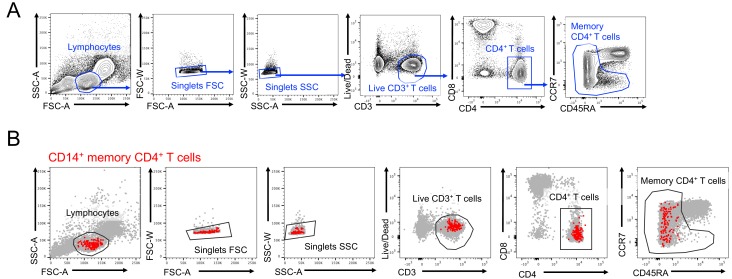
Identification of a CD14 +population within memory CD4 T cells.(A) Gating strategy to isolate bulk memory CD4+ T cells. (B) Backgating of CD14+ cells within sorted memory CD4+ T cells.